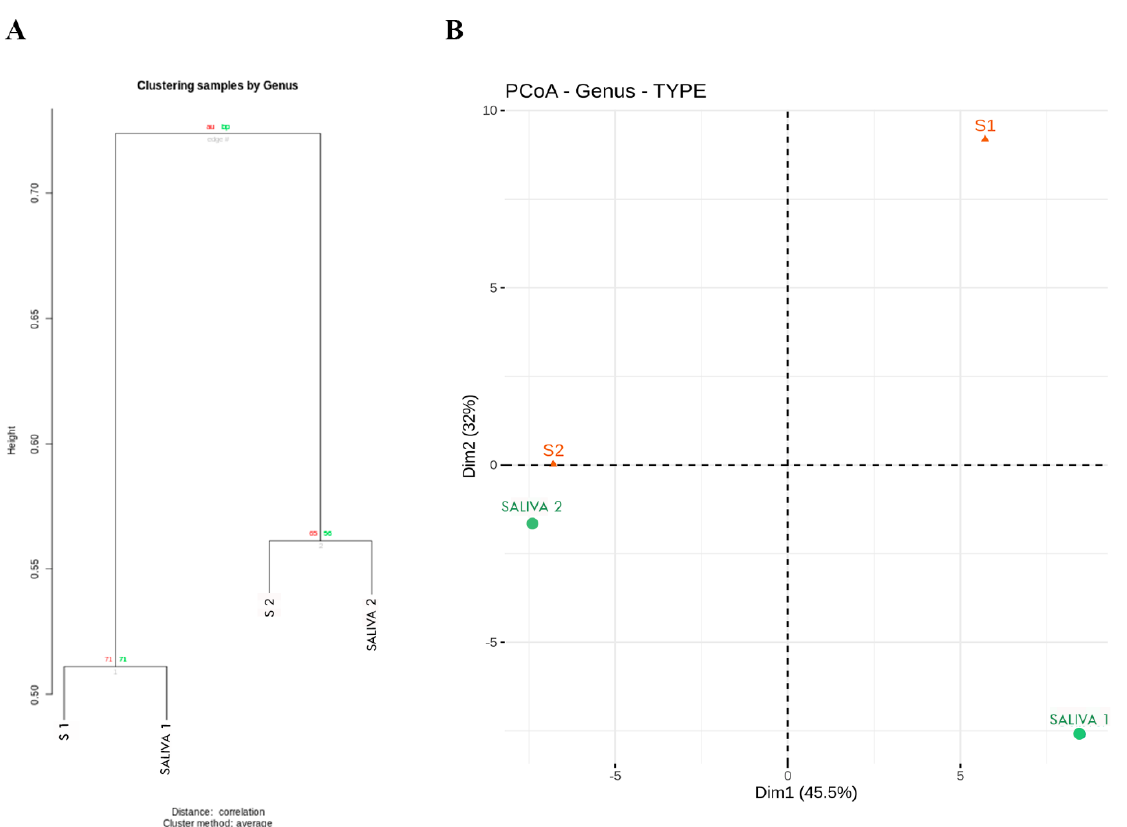
Figure 6. Characteristics of the clusters of samples: ( A ) Identified clusters of the taxa of the saliva and subgingival plaque samples at baseline and post-therapy; ( B ) principal coordinates analysis (PCoA) with weighted UniFrac distances of the samples by cluster assignment. S1, baseline subgingival sample; S2, post-therapy subgingival sample; Saliva 1, baseline saliva sample; Saliva 2, post-therapy saliva sample.